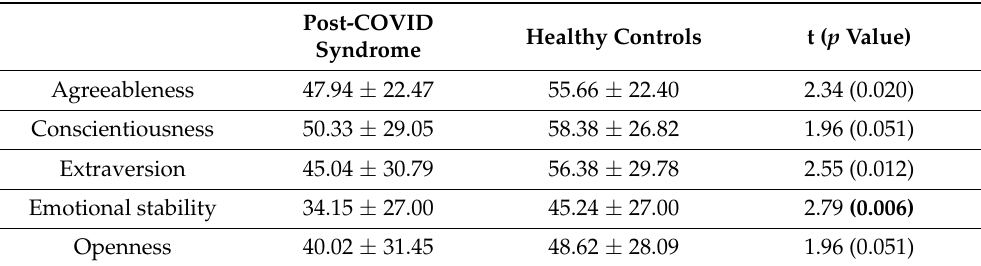
Table 2. Comparison of Big Five personality traits between patients with post-COVID syndrome and controls.